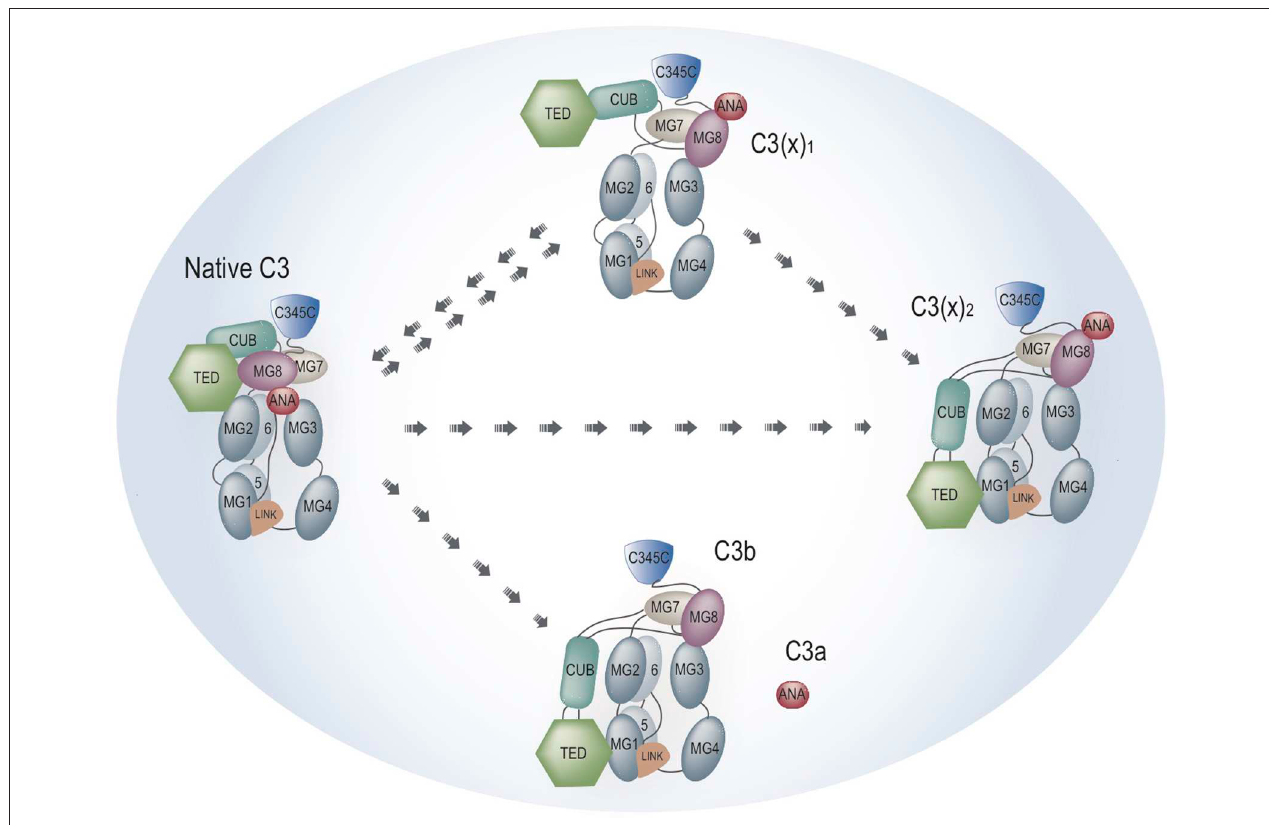
FIGURE 1 | Schematic illustration of the different forms of non-proteolytically activated C3 i.e., C3(x).